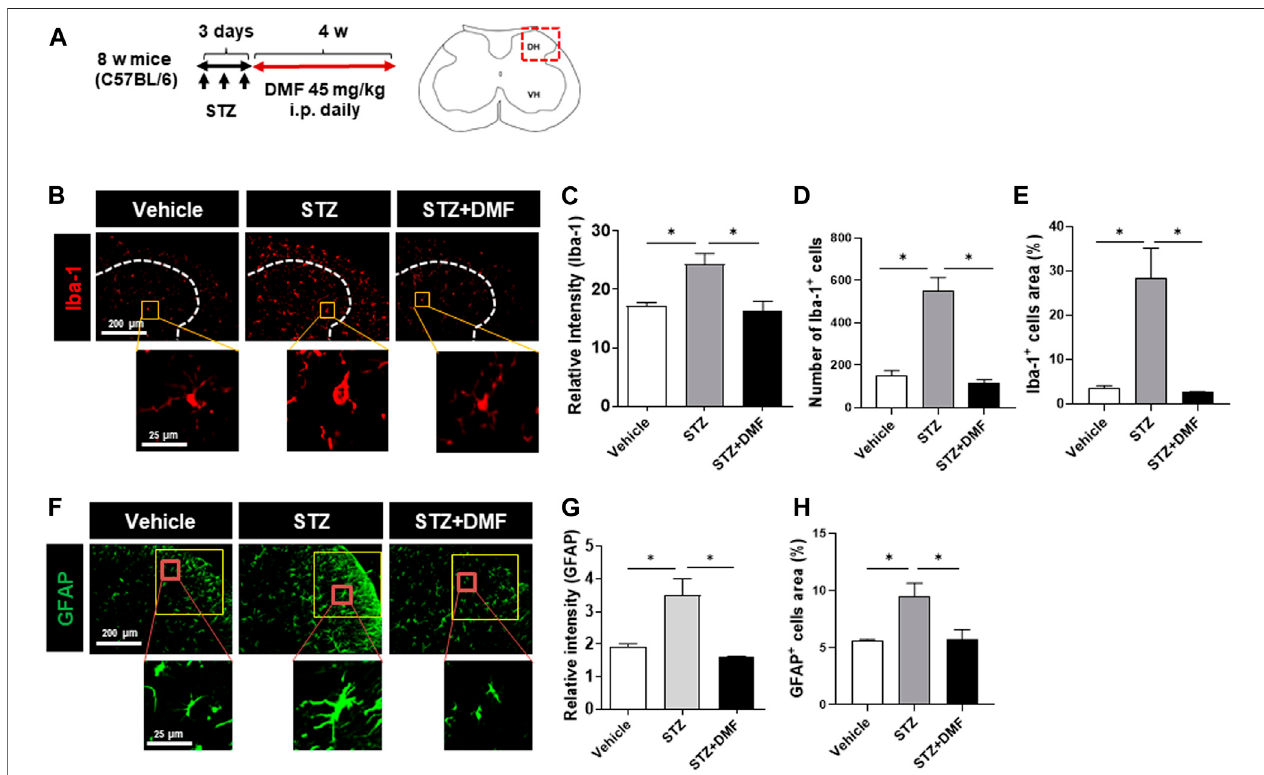
FIGURE 1 | Dimethyl fumarate reduces gliosis in the spinal cord of mice with STZ-treated diabetic neuropathy (A) C57BL/6 mice were injected with STZ (100 mg/kg, i.p.). After 3 days, the mice that developed diabetes were administered dimethyl fumarate (DMF, 45 mg/kg i.p.) once a day for four weeks. At the end of treatments, spinal cord sections wereprepared and stained withanti-Iba-1 (B – E) or anti-glial fi brillary acidic protein (GFAP) antibody (F – H) . White dotted lines represent the dorsal horn of the spinal cord. Representative Iba-1 + microglia are shown in the magni fi ed images. The quanti fi ed relative fl uorescence intensity for Iba-1 + cells (C) ,numberofIba-1 + cells (D) ,andtheareaofIba-1 + cellsinthespinalcord (E) wereanalyzed.RepresentativeGFAP + astrocytesareshowninthemagni fi edimages (F) . The quanti fi ed relative fl uorescence intensity for GFAP + cells (G) and the area of GFAP + cells in the spinal cord (H) were analyzed ( n (cid:2) 3 mice/group, 3 images/mouse). Data are presented as means ± standard error of the mean (SEM). * P < 0.05 compared with STZ-treated mice from ANOVA, Tukey ’ s multiple comparison test.